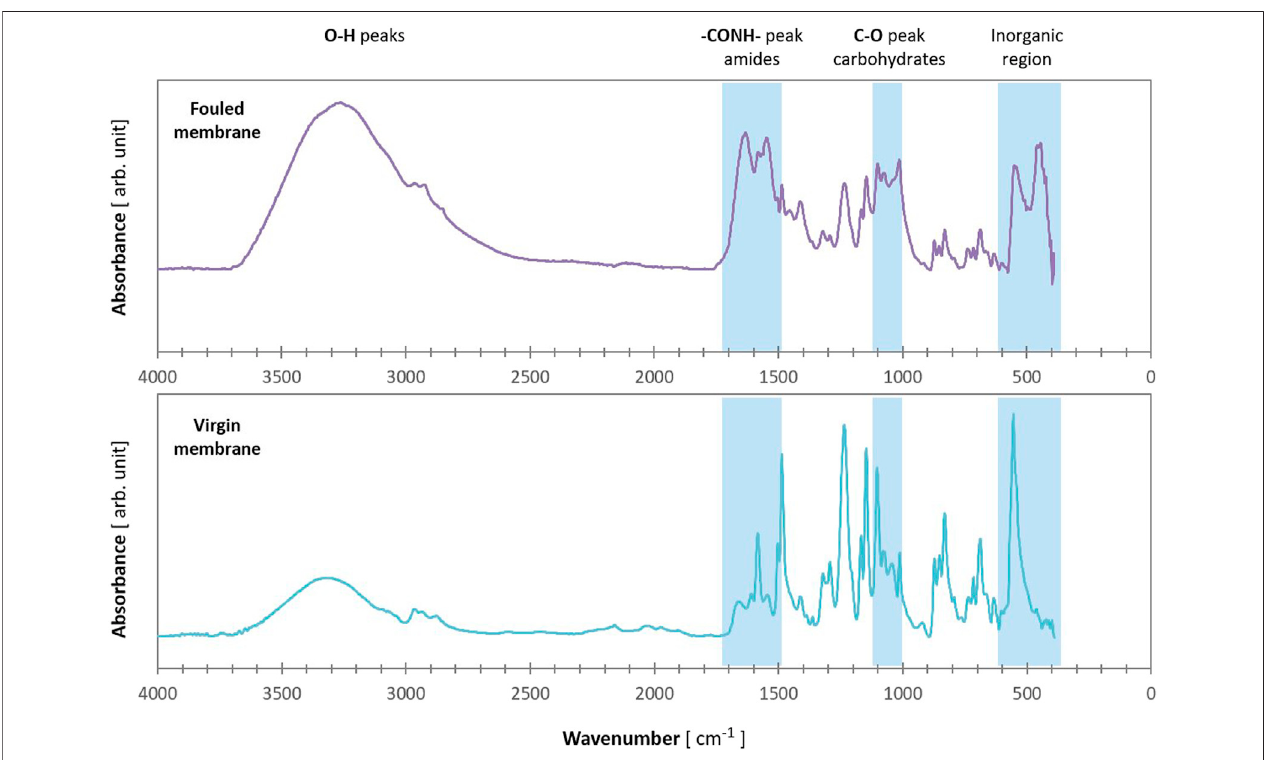
FIGURE 5 | Infrared spectra of fouled and virgin reverse osmosis membrane.